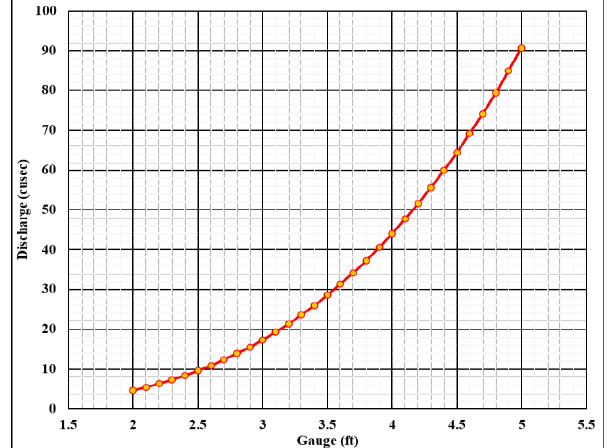
Figure 4: Illustrate the RC of the stage-discharge relationship Table 1: Illustrates RT for the different stage-discharge